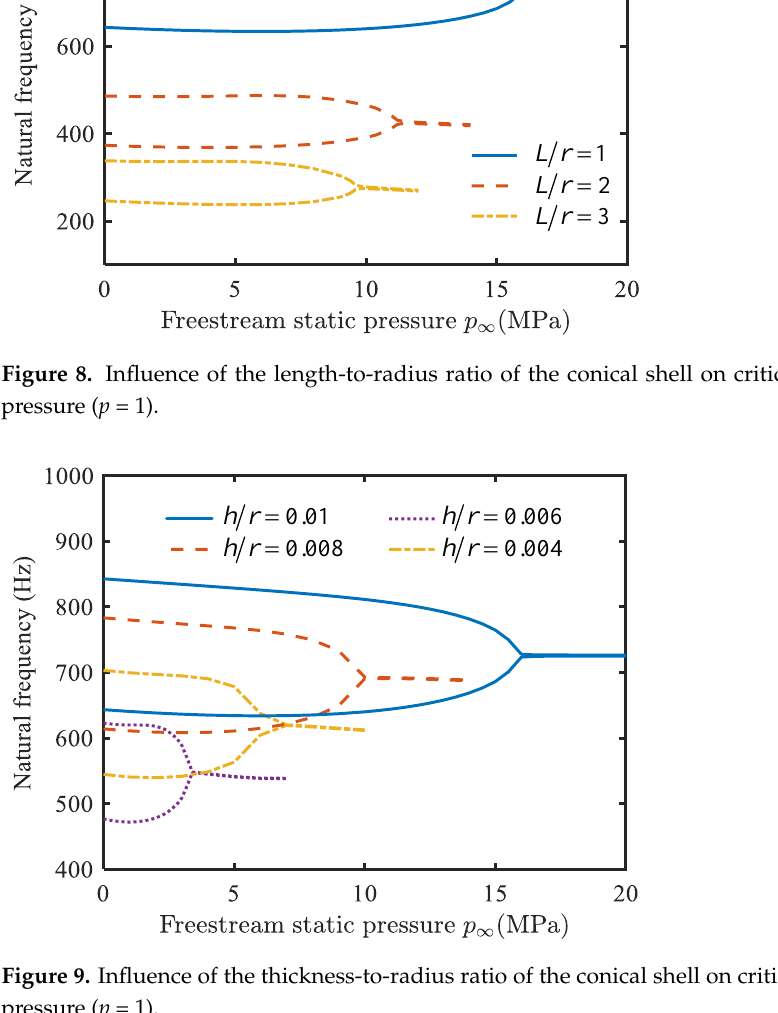
Figure 10. Influence of semi-vertex angle of conical shell on critical free-stream static pressure ( p = 1). Figure 11 describes the variation of the critical free-stream static pressure of conical shell with Mach number. It can be observed from Figure 11 that as the Mach number in- creases, the critical free-stream static pressure decreases. The variations in the critical free- stream static pressure of the conical shell with different temperature change